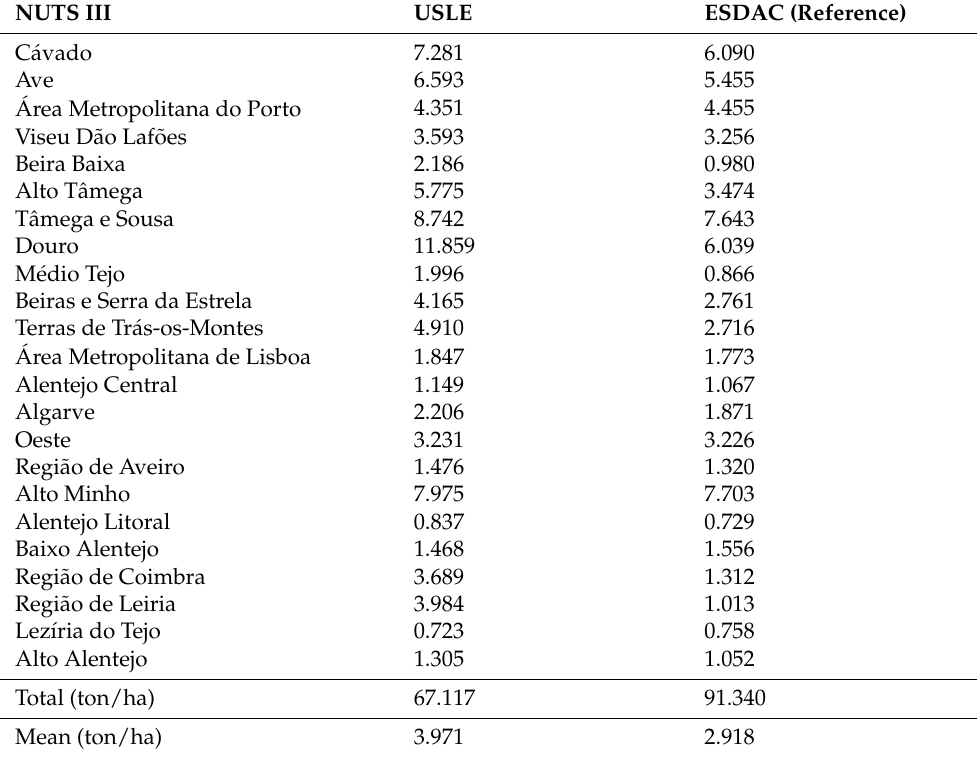
Table 5. Soil loss average value (ton/ha) for each NUTS III region in mainland Portugal, according to model output (USLE) for year 2018. Source: ESDAC